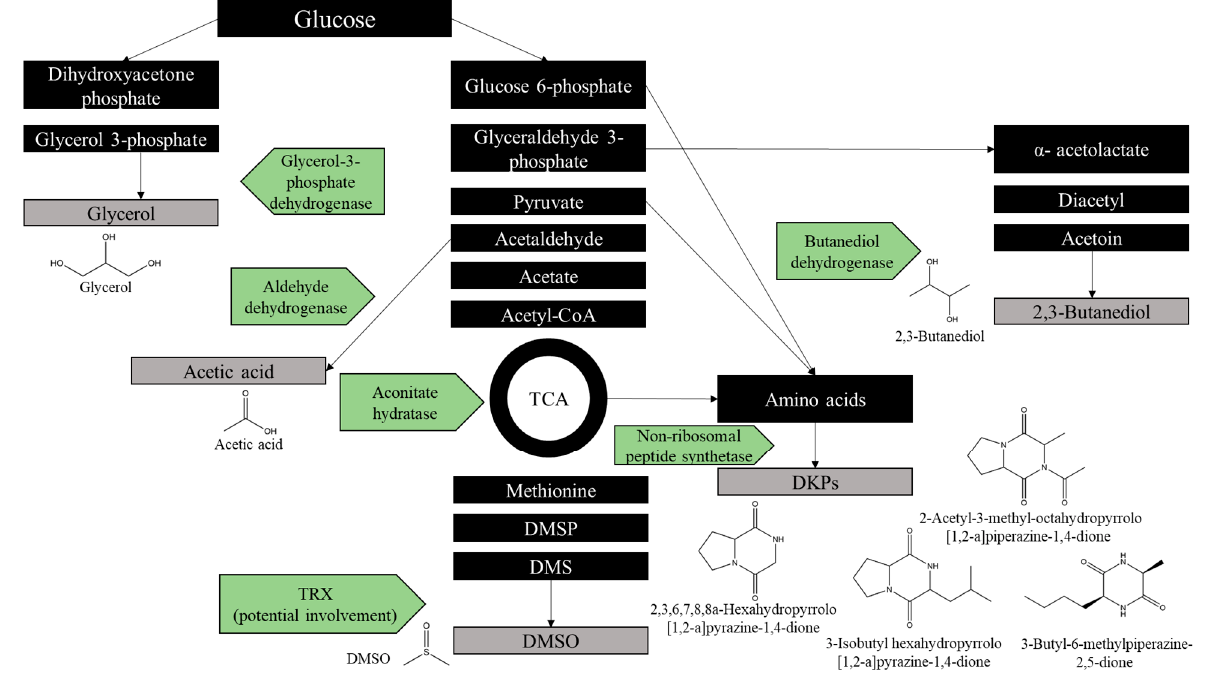
Figure 3. Potential synthetic pathway for AMMs that presented protein fragments that may have originated from metabolic pathway enzymes. The figure shows the proposed AMM pathways that biosynthesize both metabolites (based on GC/MS data) and protein fragments of metabolic enzymes (based on MS/MS data). Pathways include the tricarboxylic acid cycle (TCA), as well as the butanediol, glycerol and acetic acid pathways.